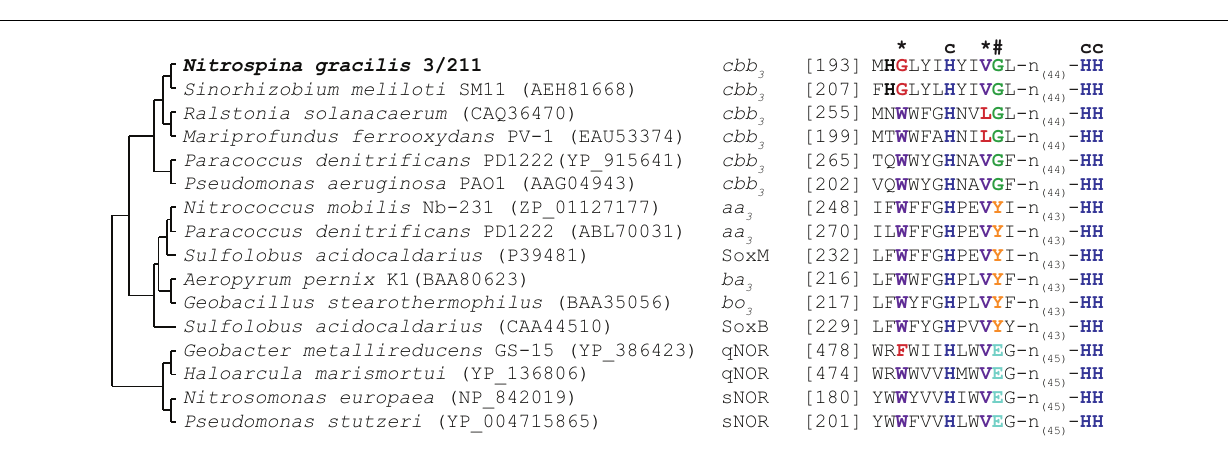
(FMN)-bindingpatternswithinsubunitNuoF.The nuoA-M